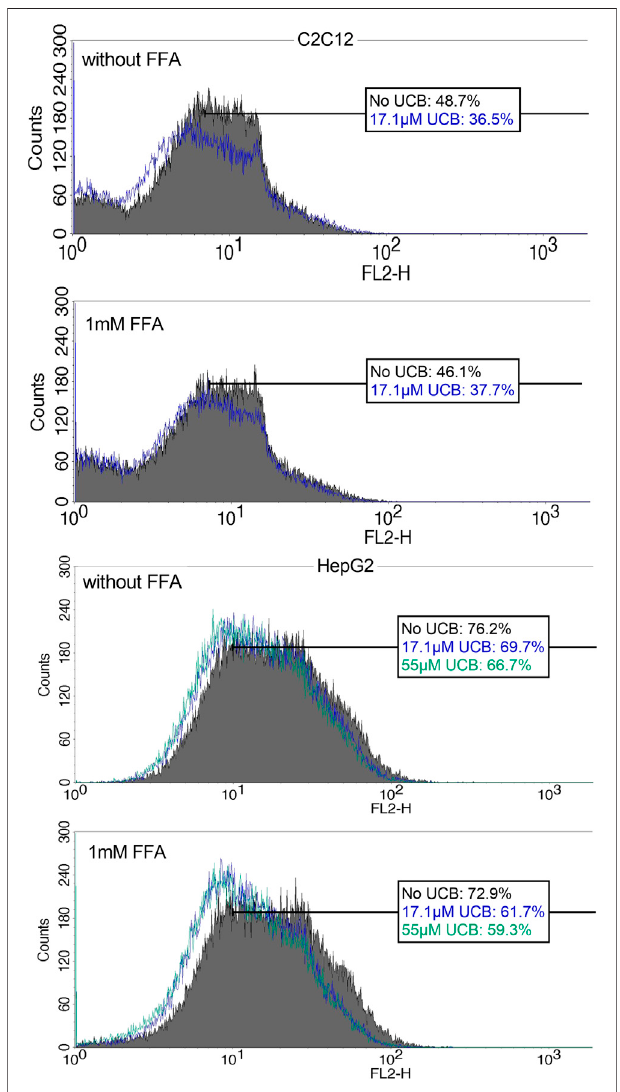
FIGURE8| NR fl uorescenceindicatesadecreasedlipidaccumulationin C2C12 and HepG2 cells upon UCB exposure. Cells were exposed to the respective treatments for 5 h at hypoglycaemic conditions. Cell associated fl uorescence was analyzed by fl ow cytometry (FL2). The blue (17.1 µM UCB) and green (55 µM UCB) histograms show a shift to the left toward decreased NR fl uorescence intensity in comparison to the gray histogram (without UCB). The boxes show the % of cells with a higher NR fl uorescence intensity after incubation without UCB, with 17.1 µM or 55 µM UCB. Representative histogram of Supplementary Tables S2 of 50,000